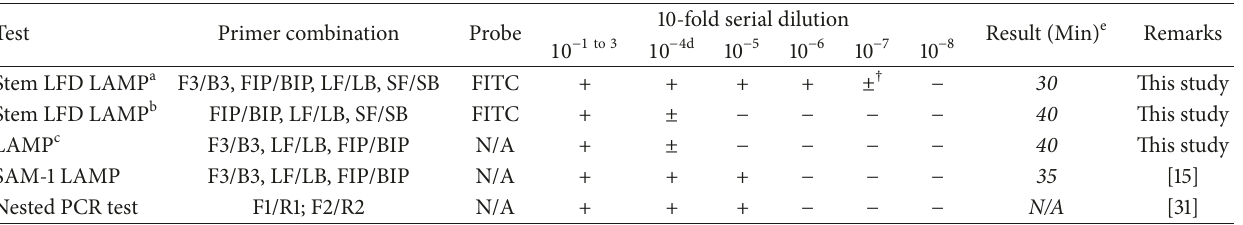
Table 2: The analytical sensitivity of stem LFD LAMP test formats, SAM-1 LAMP, and PCR tests using a 10-fold serial dilution of C. hominis DNA.